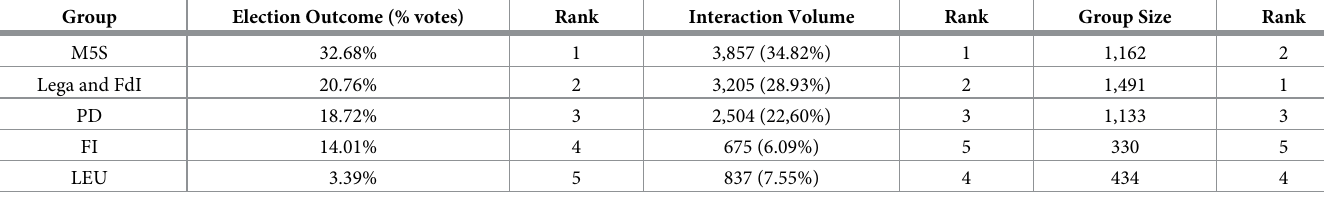
Table 3. Network analysis of groups in the social bulk reflect election outcomes. The five political ecosystems from the bulk network are ranked against their topological features: i) interaction volume, i.e. the number of social actions within the group; ii) size, i.e. the number of individuals in the group. The rank based on online interactions strongly mirrors the election outcome (Spearman ρ = 0.9, p-value = 0.039), supporting the hypothesis that online social interactions are tightly entwined to outcomes and events in the real-world. Group